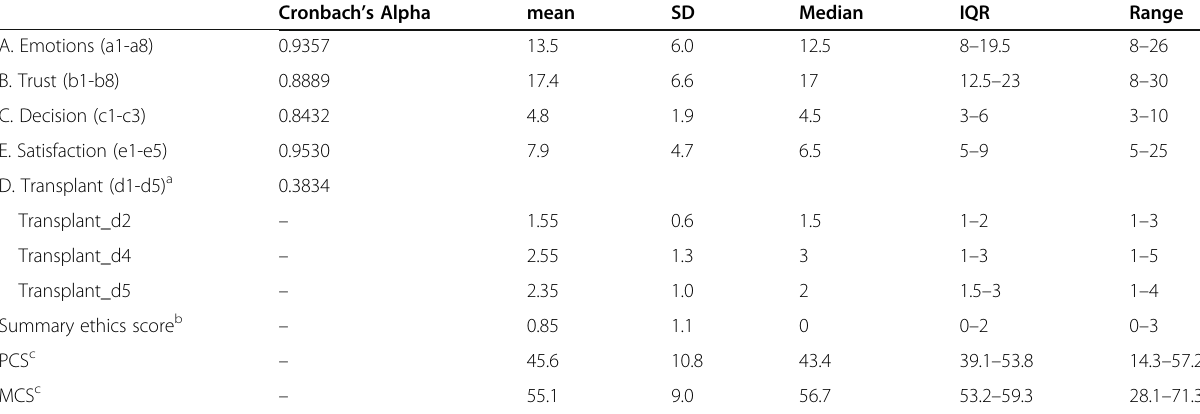
Table 4 Internal consistency reliability; distribution of scales, items, and summary ethics score; and construct validity scores